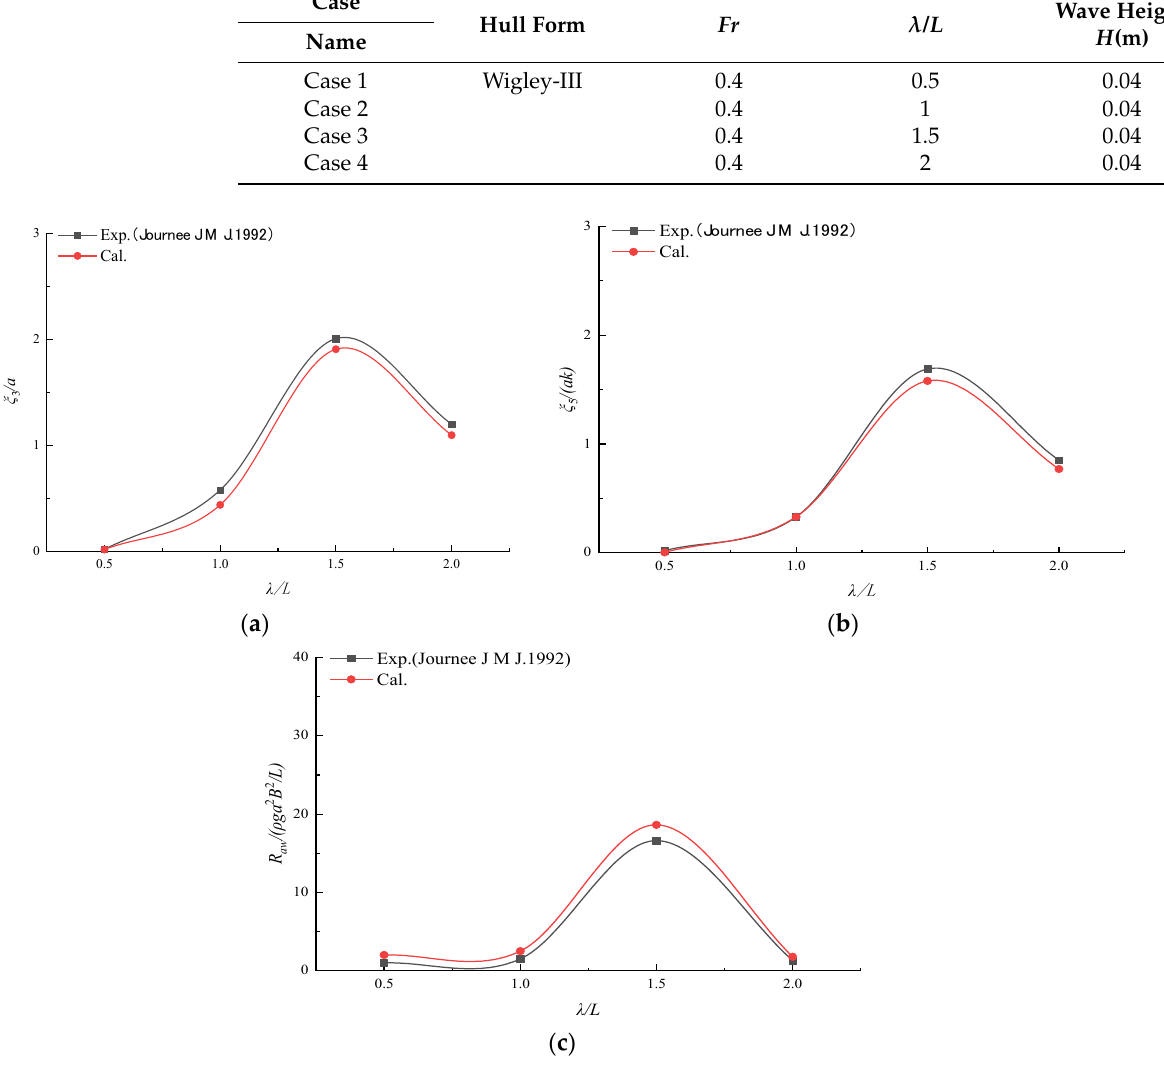
Figure 4. Comparison of ( a ) heave, ( b ) pitch and ( c ) added resistance coefficient of Wigley-III in head wave between the numerical and experimental results [17].